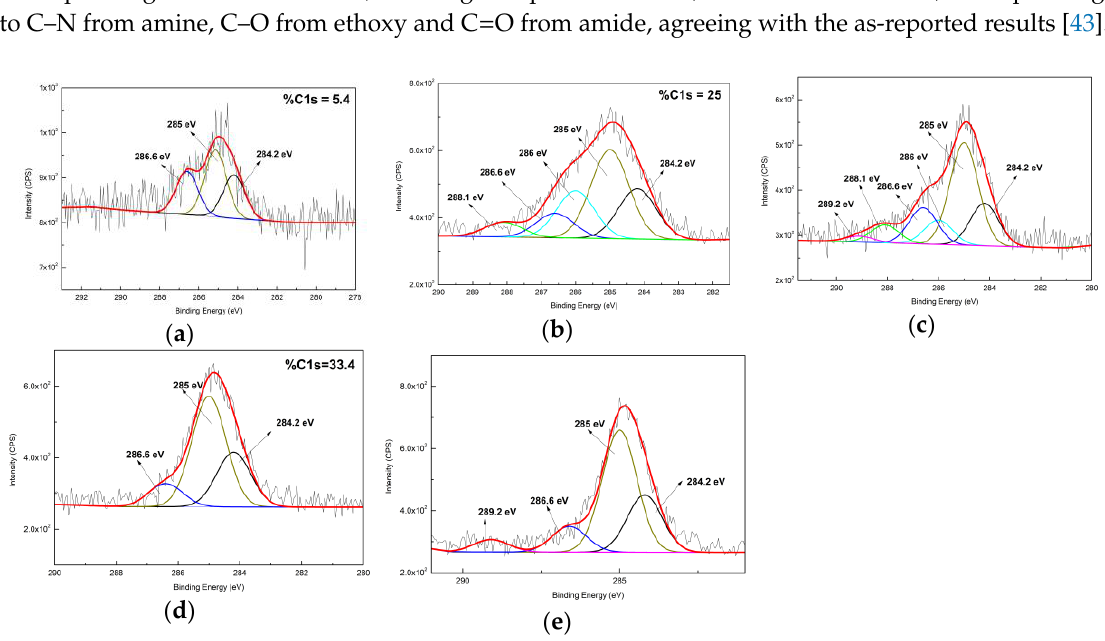
Figure 5. High resolution C 1s spectra of zeolite, silane deposited zeolite and AuNPs immobilized zeolite: ( a ) untreated zeolite; ( b ) APTES deposite zeolite; ( c ) Au@zeolite-APTES; ( d ) MPTES deposited zeolite; ( e ) Au@zeolite-MPTES.